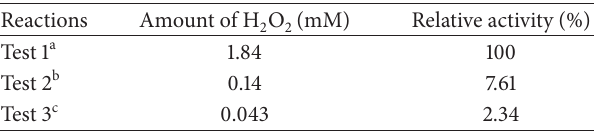
Table 4: Detection of the H Hydrogen Peroxide/Peroxidase Assay